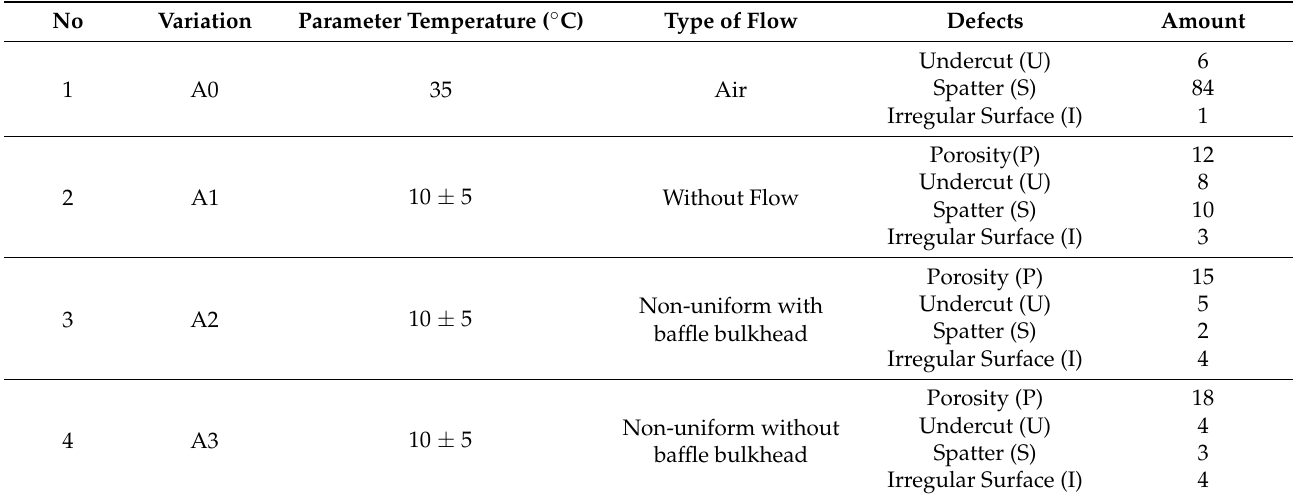
Table 2. Defects identified by visual observations.